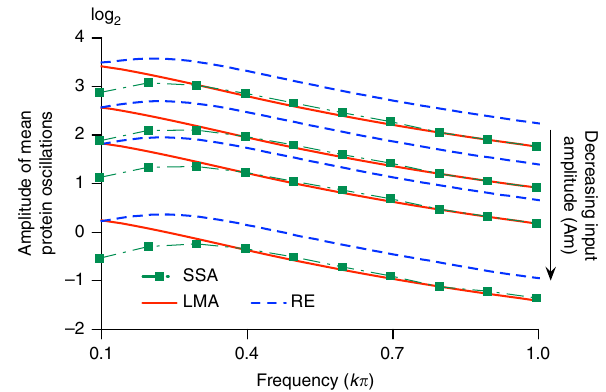
Fig. 4 Dependence of the LMA approximation error on parameters in the oscillatory feedback loop. The fi gure shows a plot of the amplitude of the oscillations in mean protein number as a function of the frequency of the oscillatory transcription ( k π ) and of its amplitude (Am). This is obtained using the LMA (red solid line), the SSA (green squares) and the deterministic rate equations (RE, dashed blue line). The results shows that the rate equations cannot predict the amplitude precisely but capture the weak resonance phenomenon while the LMA gives precise predictions at high frequencies, but cannot capture the resonance. The frequency selectivity of the LMA is due to its time-averaging assumption. The oscillatory feedback loop is the one shown in Fig. 2c with ρ u = 20, ρ b = 0, σ = 0.04, σ = 0.25, and Am is selected to be 0.9, 0.5, 0.3, 0.1 (from top b u to bottom). Note that the transcription rate in the active promoter state is